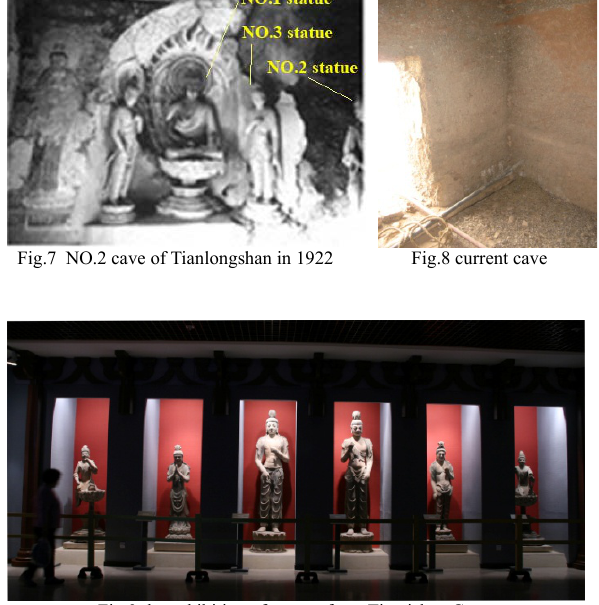
Fig.4 Jingmu Tower in Sichuan